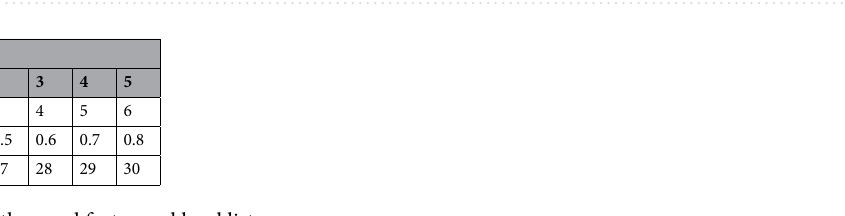
Table 3. The orthogonal factor and level